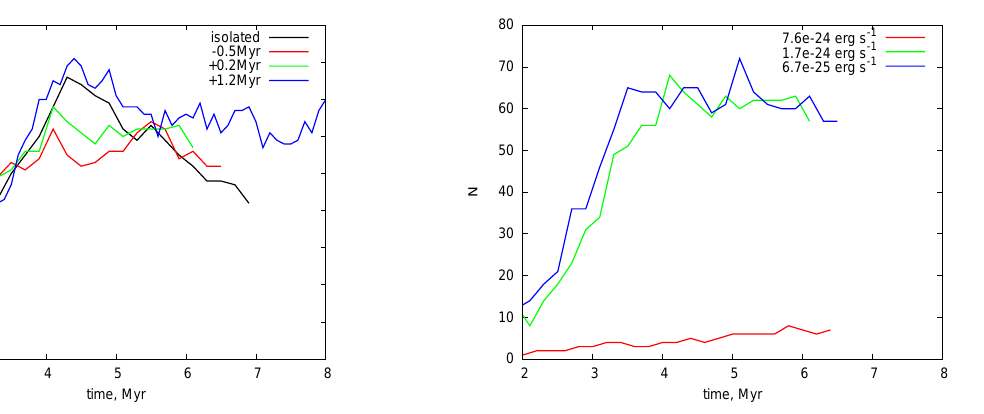
Figure 4. Number of cold and dense fragments in the isolated bub- ble (black line) and two colliding bubbles depending on the age of the bubbles: (a) SNe explosions exhausted 0.5 Myr after the merg- ing (label ’-0.5Myr’, red line), (b) SNe exhausted 0.2 Myr before the merging (label ’+0.2Myr’, green line), (c) SNe exhausted 1.2 Myr before the merging (label ’+1.2Myr’, blue line). The value along the x-axis is the age of the bubbles.